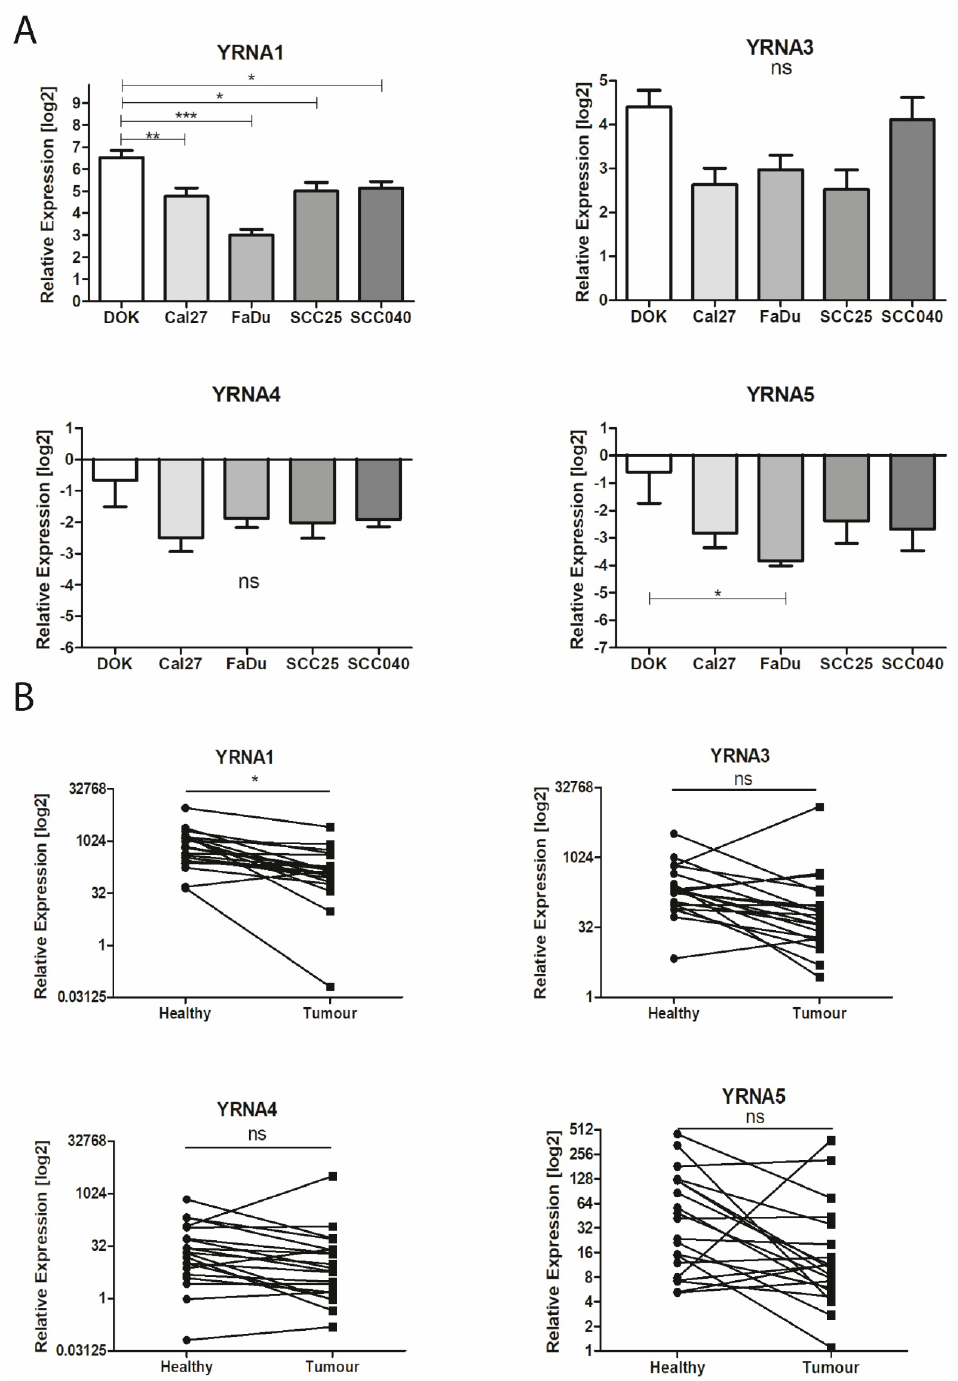
Figure 1. Expression levels of YRNA1, YRNA3, YRNA4, and YRNA5 in head and neck squamous cell carcinoma (HNSCC). ( A ) Dysplastic oral keratinocyte (DOK), Cal27 and SCC-040 cell lines, one-way analysis of variance (ANOVA) with Tukey’s multiple comparison post-test; the graphs show relative expression and means of value with SEM; ( B ) patients’ tumours and healthy tissue samples, paired T-test; * p < 0.05; ** p < 0.01; *** p < 0.001; ns—not significant.